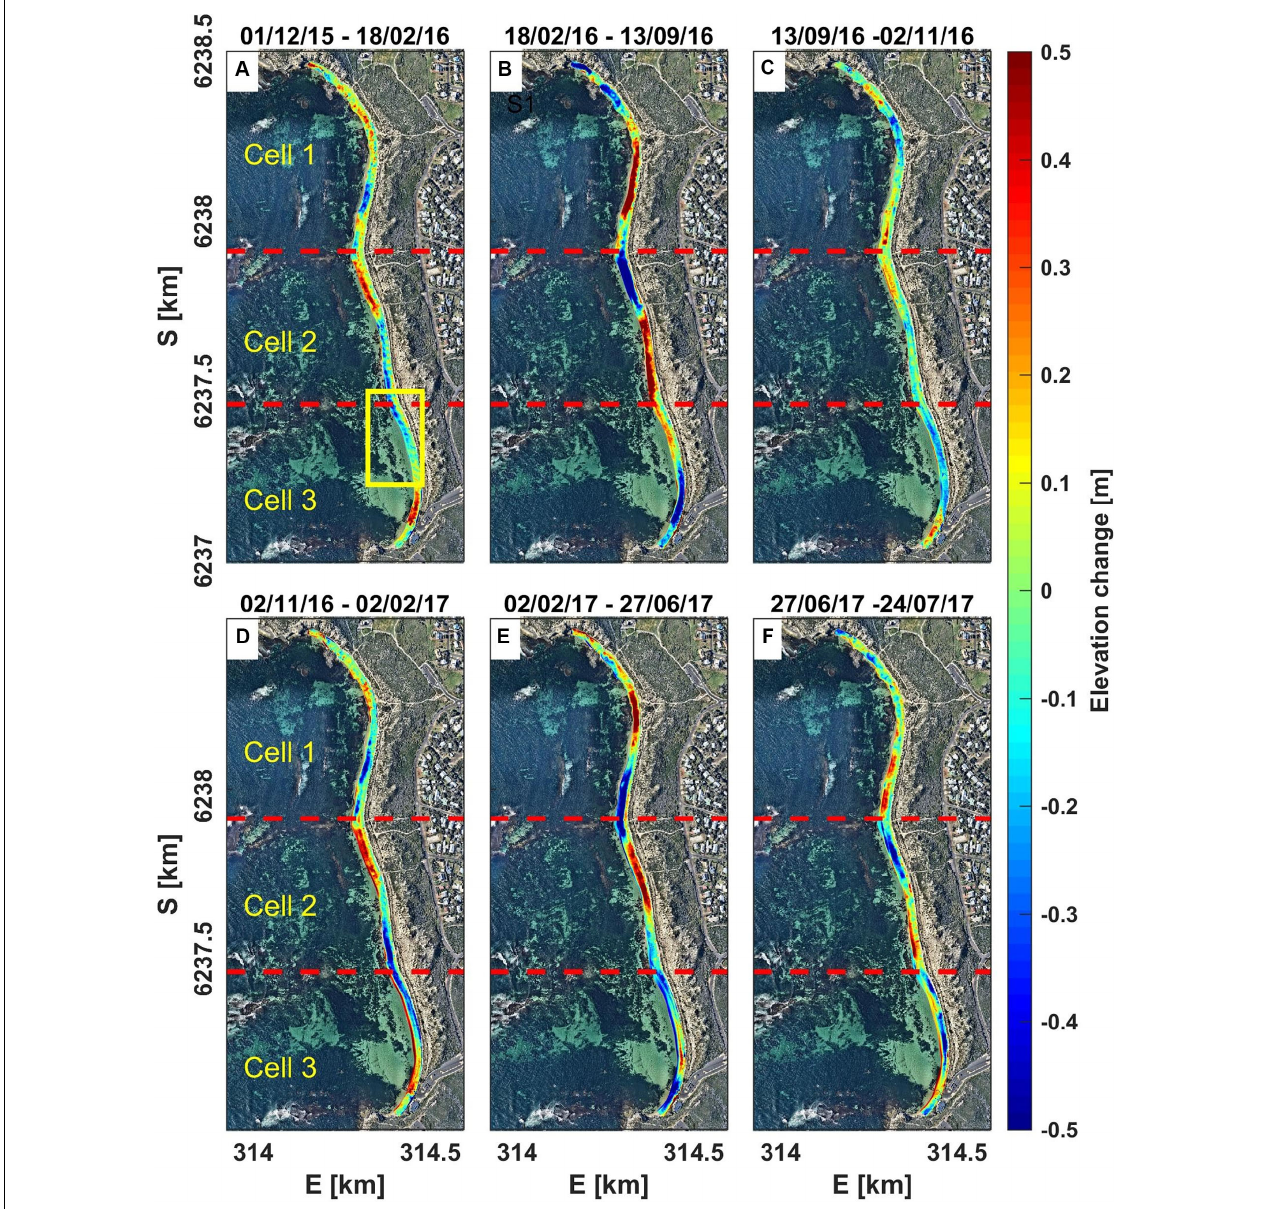
FIGURE 8 | Beach elevation changes within period of (A) 01/12/2015-18/02/2016, (B) 18/02/2016-13/09/2016, (C) 13/09/2016-02/11/2016, (D) 02/11/2016-02/02/2017, (E) 02/02/2017-27/06/2017, (F) 27/06/2017-24/07/2017, separated into three cells (Cell 1-Cell 3) based on the position of anti-nodes located behind the offshore reefs (red-dashed lines). The yellow box in figure (A) is the area covered by video camera